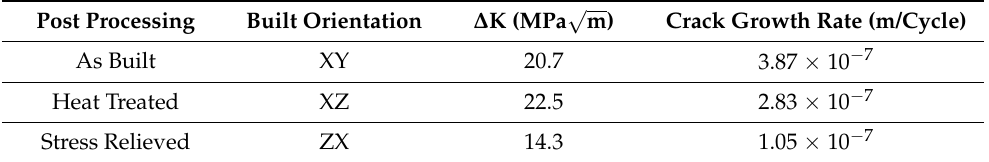
Table 2. Sample of collected data for Ti-64